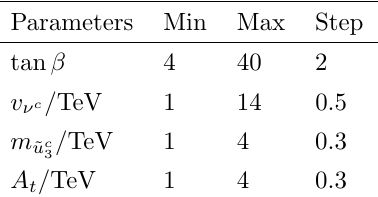
3 (cid:21)(cid:29) (cid:23) c (cid:17)